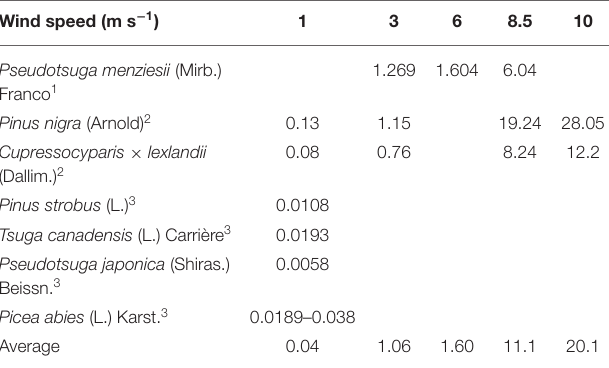
(3) the length of the transition periods. We parameterized leaf- on and leaf-off dates as the average of the dates of first and last frost events (www.weatheronline.co.uk). For Berlin, the day-of- year (doy) leaf-on and leaf-off dates are April 2nd (doy 92) and November 1st (doy 305); for Munich, April 5th (doy 95) and November 4th (doy 308); and for Rome, February 27th